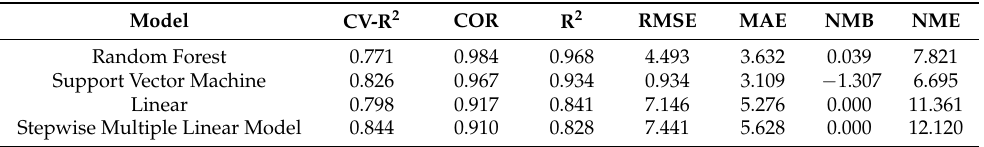
Table 5. Models and performance evaluation. (CV-R 2 , COR, R 2 , RMSE, MAE, NMB and NME mean the cross-validation R-squared, the correlation coefficient, R-squared, the root mean square error, the mean absolute error, the normalized mean bias, and the normalized mean error, respectively).